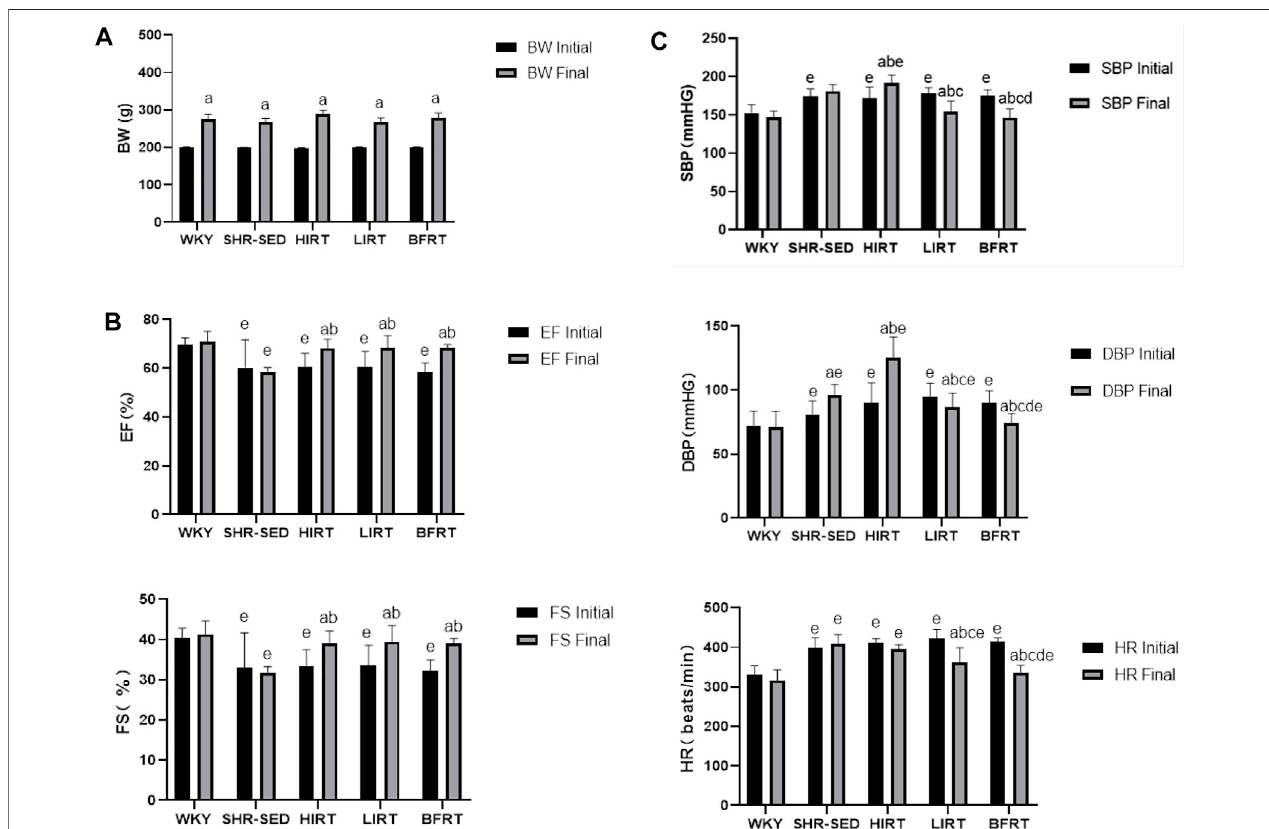
FIGURE 2 | (A) body weight; (B) cardiac function; (C) hemodynamic